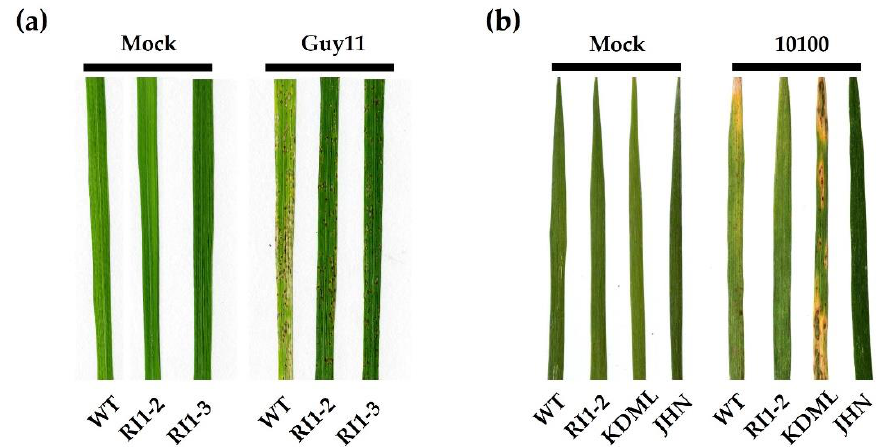
Figure 1. Disease symptoms on wild-type (WT) and OsVTC1-1 RNAi lines (RI1-2 and RI1-3) rice leaves inoculated with rice blast fungus isolates. ( a ) Guy11; ( b ) 10100, Khao Dawk Mali 105 (KDML105) and Jao Hom Nin (JHN) were used as susceptible and resistant controls, respectively. Diseased rice leaves were photographed 7 days post inoculation.